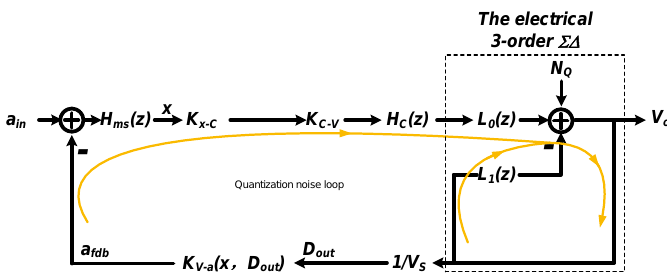
Figure 9. The signal flow diagram of the quantization noise loop.